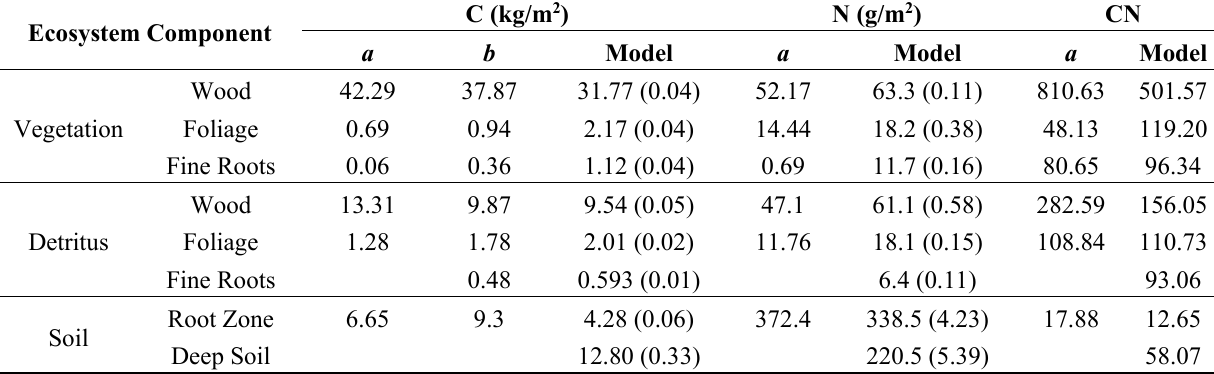
Figure 5. Measured versus model time series for stream water discharge ( a ), dissolved inorganic nitrogen ( b ) and dissolved organic nitrogen ( c ). Nash-Sutcliffe efficiencies for discharge is 0.71, for DON is 0.53. For DIN the efficiency is − 0.13, as discussed in the text, this is likely due to the clearcut that occurred in the watershed in the early 1970s. The model did not attempt to incorporate the effects of the management. Table 9. Comparison of modeled pool sizes (averaged over the 20 year simulation period) against measured values as reported in ( a ) [29] from WS10 and from ( b ) [41] from Wind River, WA. We assumed a carbon content of 50% to estimate C from the dry mass reported in [29]. The standard deviation of the modeled values is included in